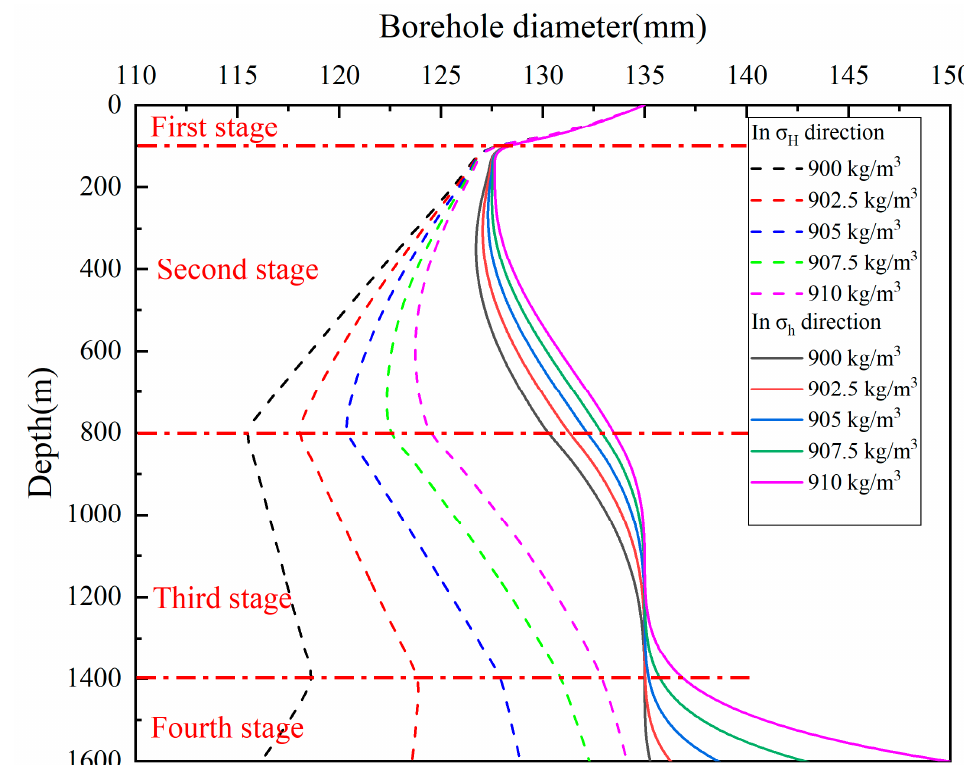
Figure 10. Sensitivity analysis of changes in borehole diameter with drilling fluid density in one year.